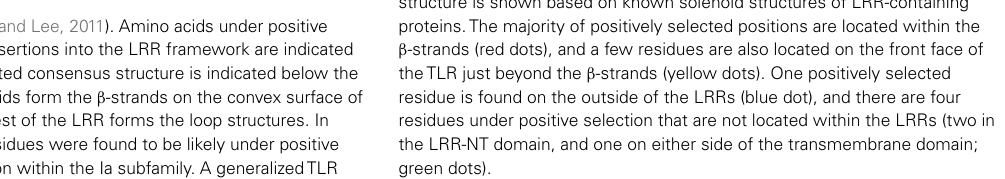
structure is shown based on known solenoid structures of LRR-containing proteins.The majority of positively selected positions are located within the β -strands (red dots), and a few residues are also located on the front face of theTLR just beyond the β -strands (yellow dots). One positively selected residue is found on the outside of the LRRs (blue dot), and there are four residues under positive selection that are not located within the LRRs (two in the LRR-NT domain, and one on either side of the transmembrane domain; green